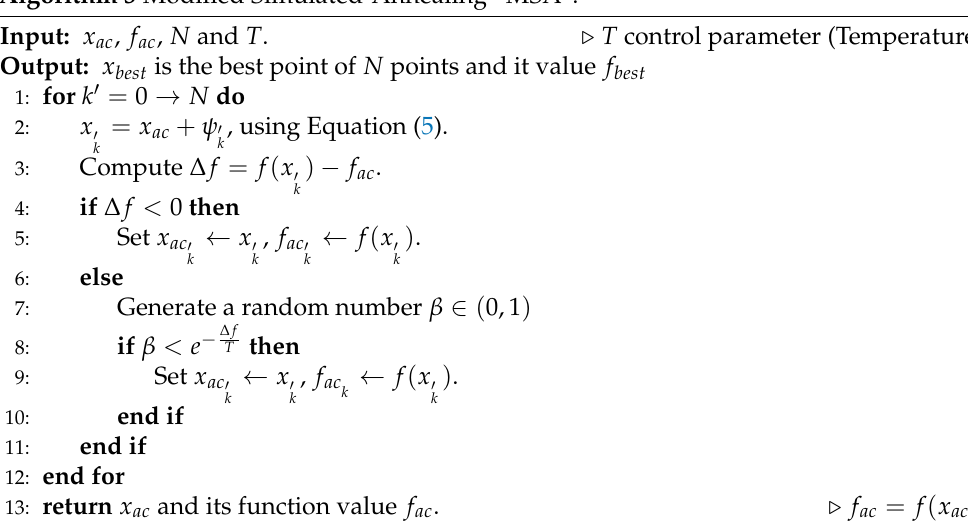
Algorithm 3 Modified Simulated-Annealing